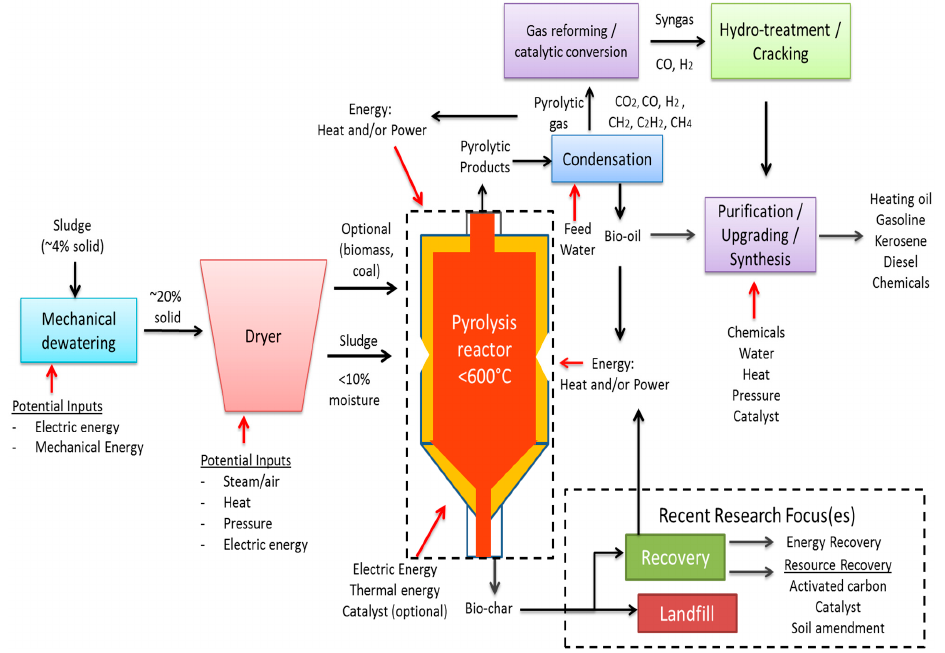
Figure 7. Schematic Representation of the Pyrolysis of Sludge.